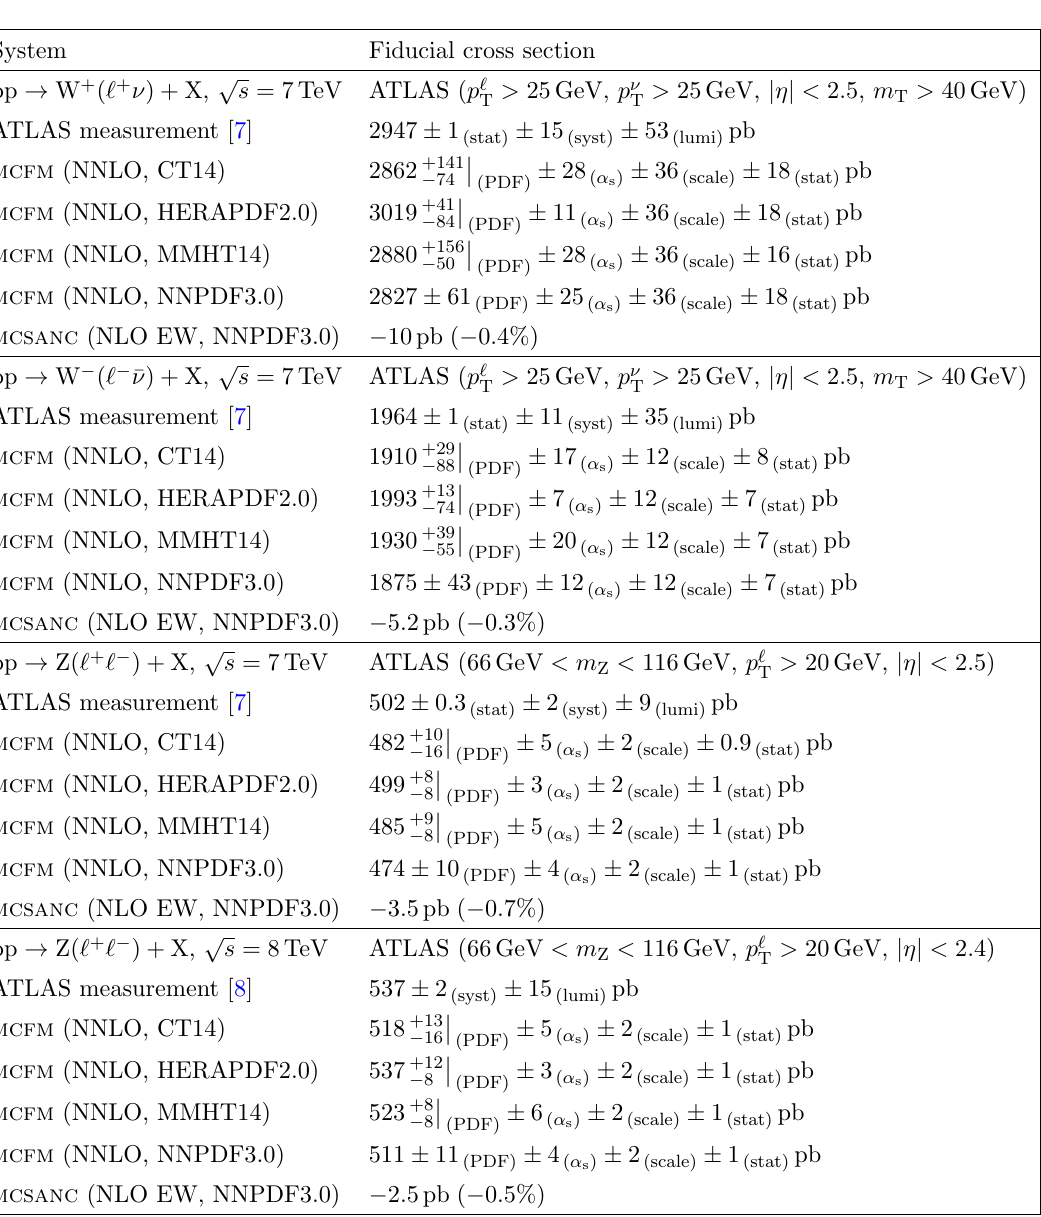
Table 5 . Comparison of the ATLAS (cid:12)ducial cross sections for W + , W (cid:0) , and Z boson production p in pp collisions at s = 7 and 8 TeV to the NNLO pQCD results obtained with mcfm using the CT14, HERAPDF2.0, MMHT14, and NNPDF3.0 PDF sets, including NLO EW